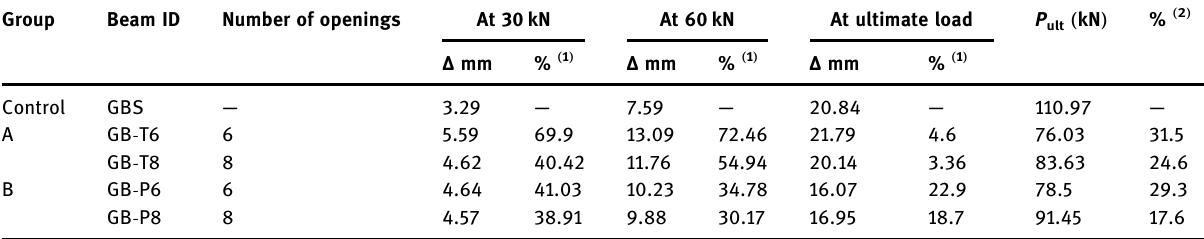
Table 5: Beams mid - span deformability at di ff erent loading